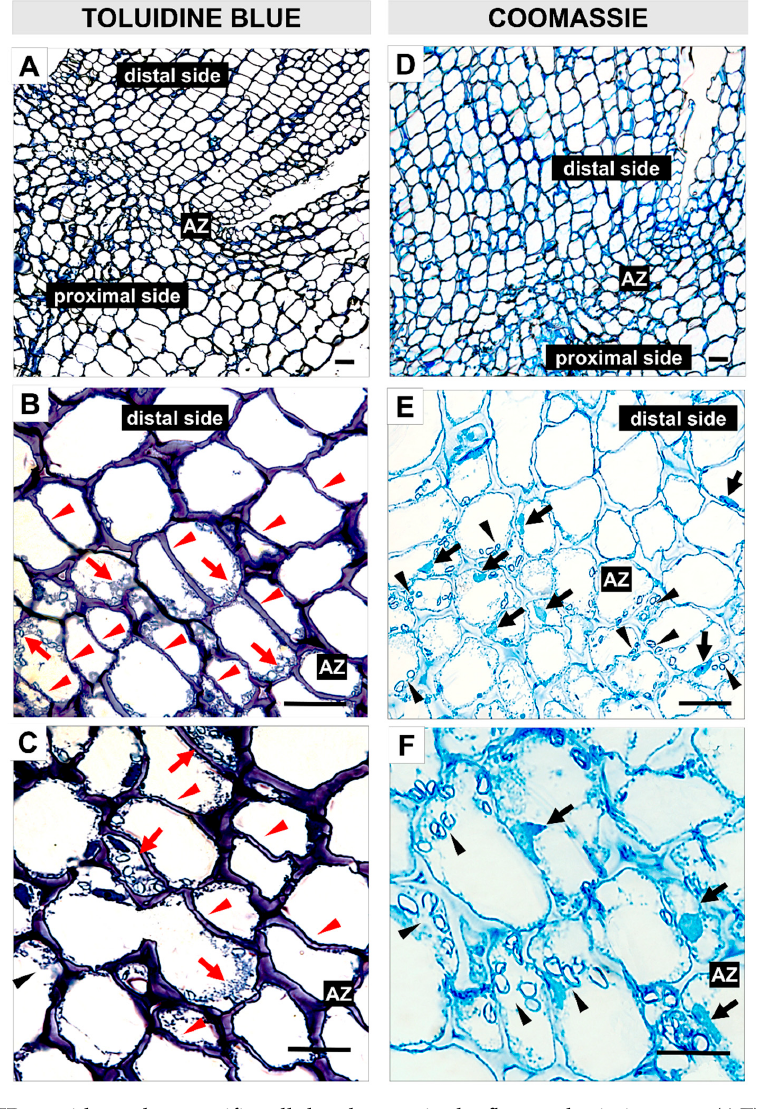
Figure 3. Synthetic EPIP peptide evokes specific cellular changes in the flower abscission zone (AZ) of L. luteus . A 100 µ M peptide solution in 0.05% Tween 20 was applied directly to the inactive AZ. For histological observations, sections of AZ were collected 24 h after the EPIP application. Fixed material was stained with toluidine blue ( A – C ) or Coomassie Brilliant Blue ( D – F ). Pictures B , C , and E , F are magnifications of different areas presented in A and D , respectively. Enlarged AZ cells ( C , F ). Red arrows indicate aggregates and small vesicles, while red arrowheads mark the place of newly formed cell walls after divisions ( B , C ). Black arrows indicate elongated, protein-rich cell nuclei, while black arrowheads correspond to the presence of aggregates and small vesicles enriched in proteins ( E , F ). Bar—40 µ